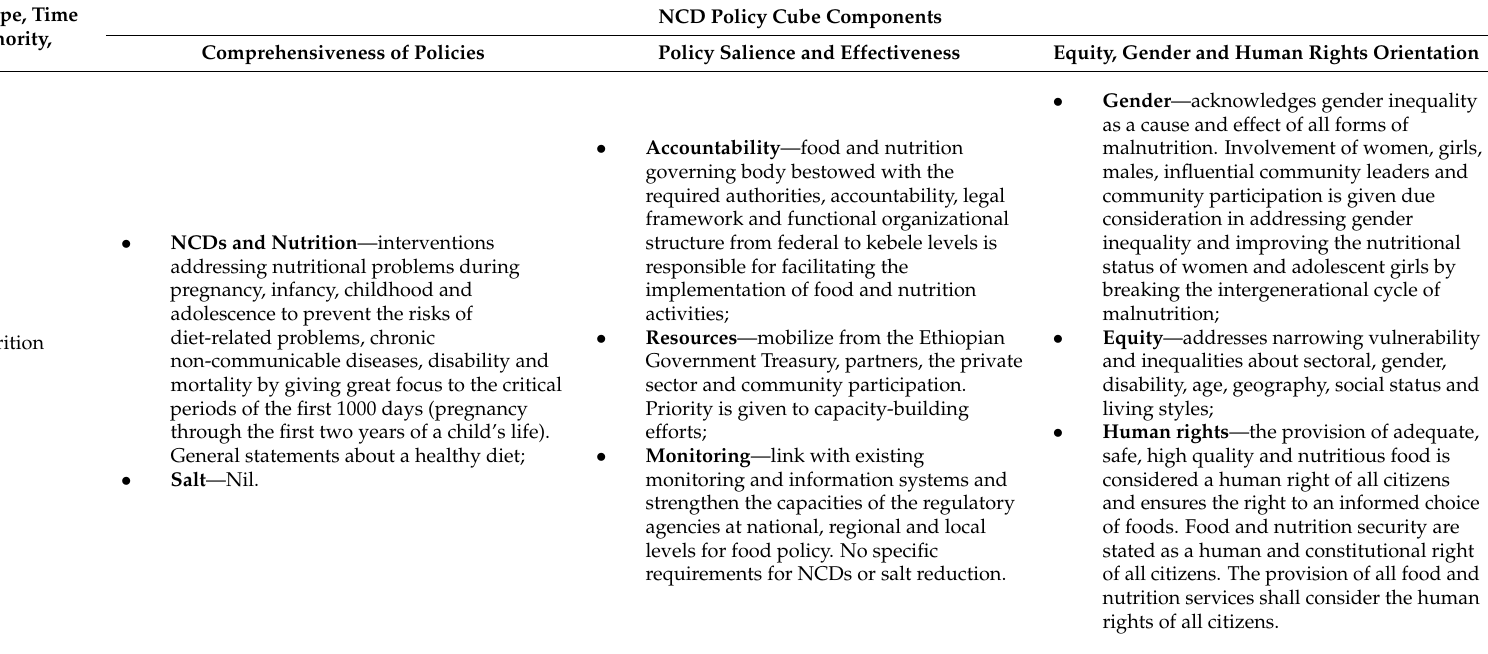
Table 2. Characteristics of included documents, 2021 ( n =